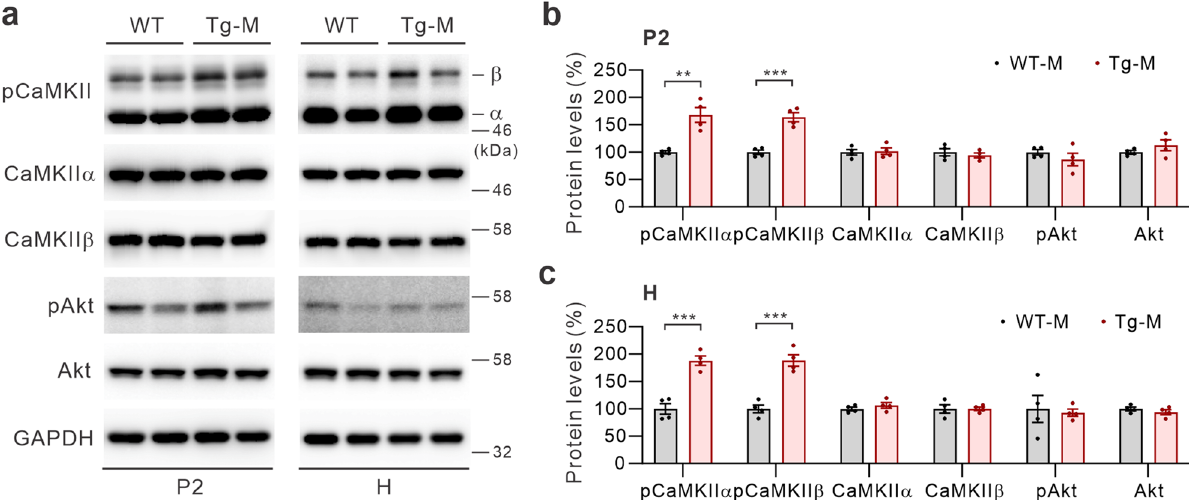
Figure 2. Enhanced CaMKII activity, not Akt, is associated with the hyper-phosphorylation of GSK3β in male S-SCAM Tg mice. ( a ) Representative immunoblots showing pCaMKIIs, CaMKIIα, CaMKIIβ, pAkt, and Akt protein levels in the P2 (left) and H fractions (right) of male S-SCAM Tg mice. ( b – c ) Quantification of P2 ( b ) and H data ( c ). n = 4 mice per group. *** p < 0.001, ** p < 0.01, unpaired t -test.